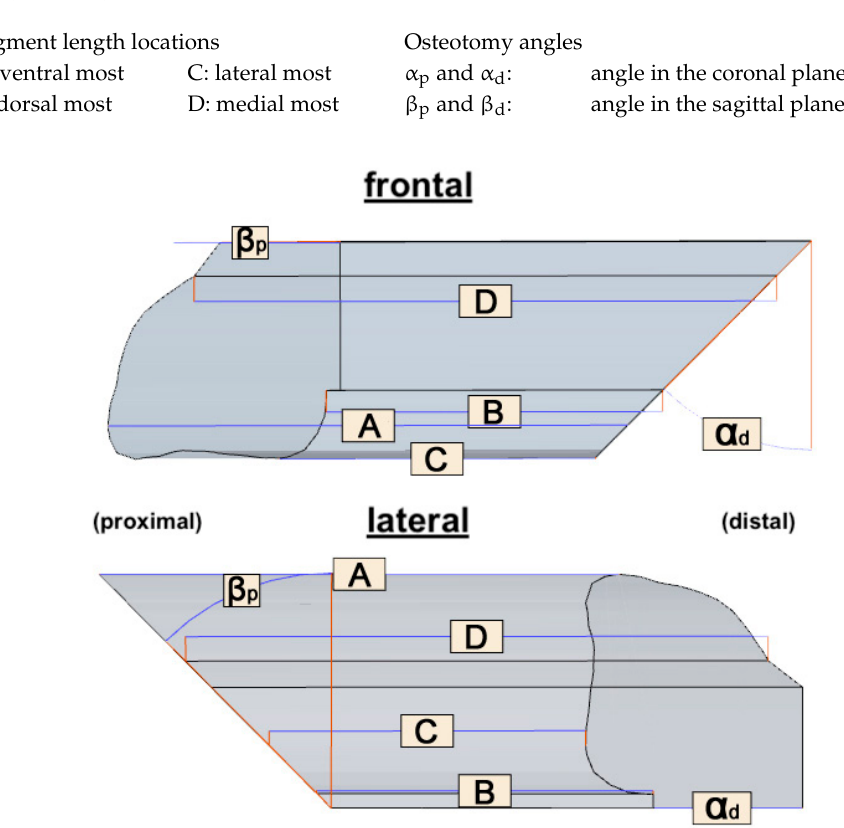
Figure 5. Assessed lengths (A: ventral, B: dorsal, C: lateral, D: medial) and varying angles from 45° to 0° ( β p : sagittal plane, α d : coronary plane α d ) of each transplant from frontal ( top ) and lateral ( bottom ). The fixed angles ( α p : coronary plane, β pd : sagittal plane) with 0° are not shown in this figure.